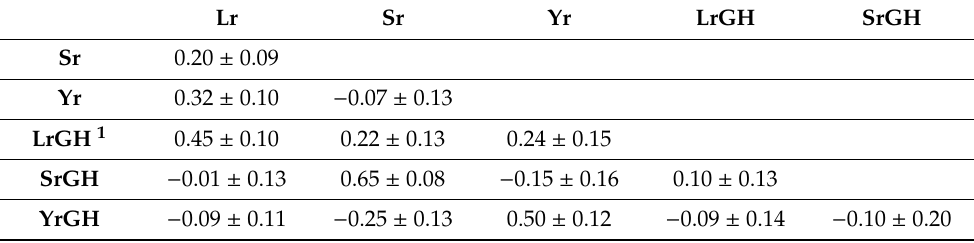
Table 4. Genetic correlations ( ± ) standard errors between field and greenhouse data.